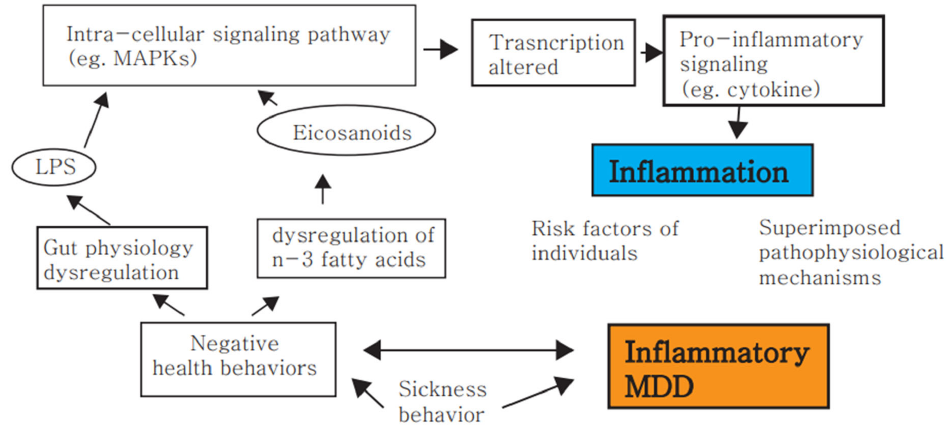
Figure 1. Assumptive model of reciprocal interactions between low ‐ grade inflammatory changes and MDD. Negative health behaviors, including poor stress ‐ coping strategies, may provoke inflammatory responses, which involve potential mechanisms mediating the effects of such negative behaviors on inflammation, dysregulation of n ‐ 3 fatty acids, and gut physiology dysregulation. This, in turn, may generate symptoms of MDD, including motivational deprivation and psychomotor impairment, further aggravating sickness behavior patterns, and may induce depression and more negative health behaviors. Abbreviations: omega ‐ 3 (n ‐ 3), lipopolysaccharide (LPS), mitogen ‐ activated protein kinases (MAPKs), major depressive disorder (MDD).